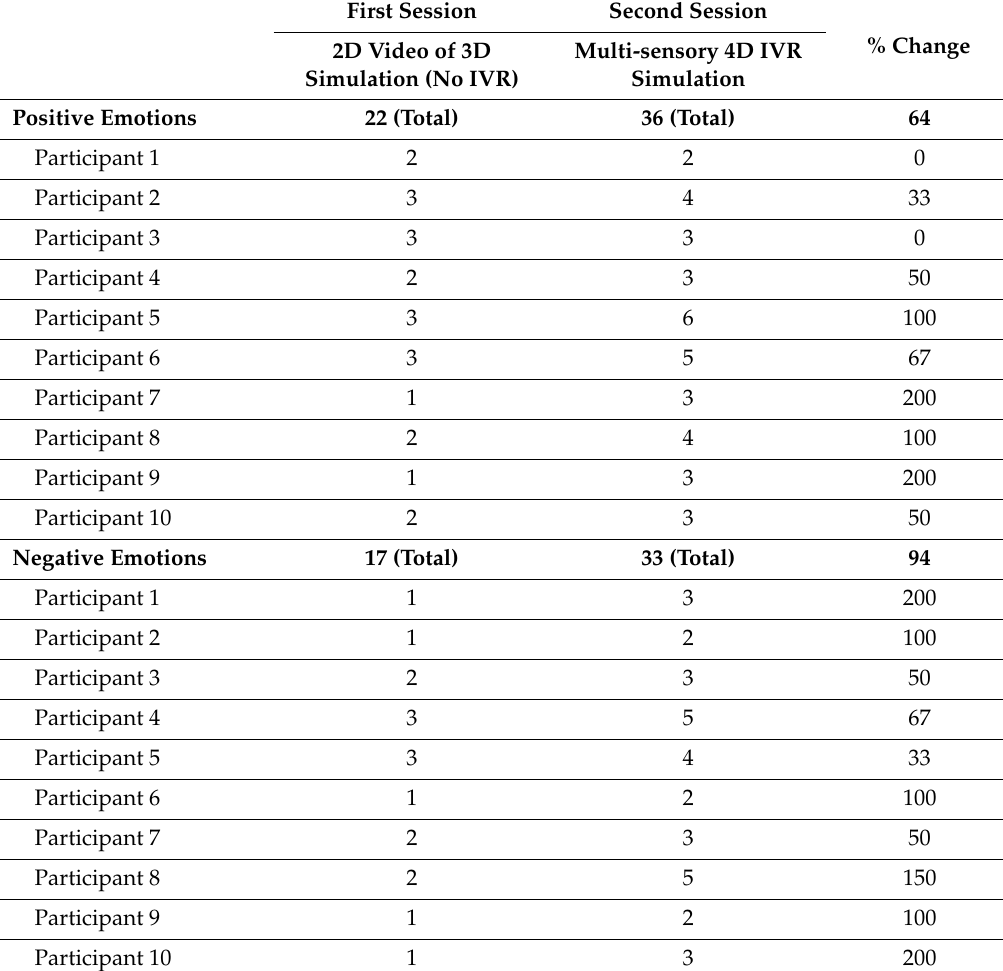
Table 4. Number of emotional responses o ff ered by focus group 4